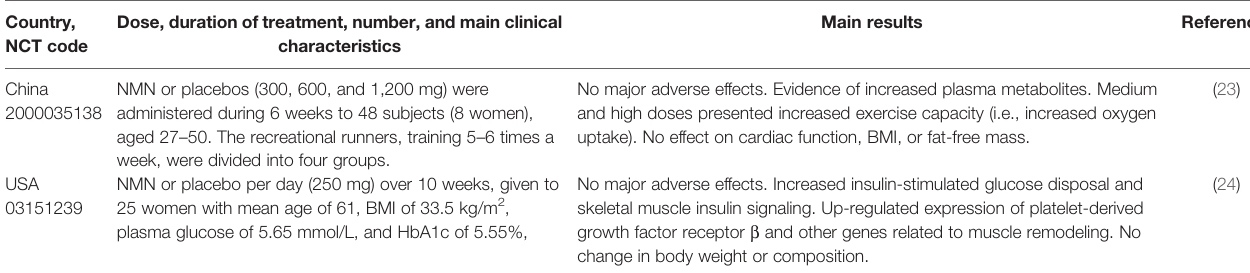
TABLE 1 | Recently (from 2018) published randomized, double-blind, placebo-controlled clinical trials that tested NMN administration on healthy individuals or in individuals with overweight and obesity. Country, Dose, duration of treatment, number, and main clinical NCT code